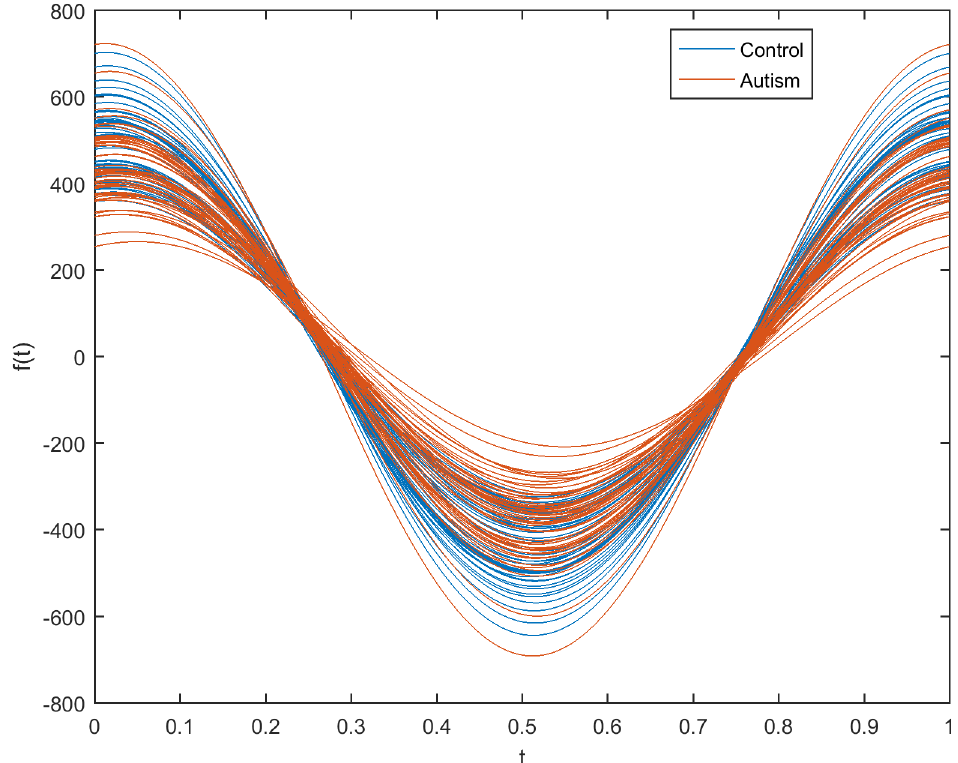
Fig 12. Andrews plot for three representative selected genes from the 200 genes filtered by the WRS method.